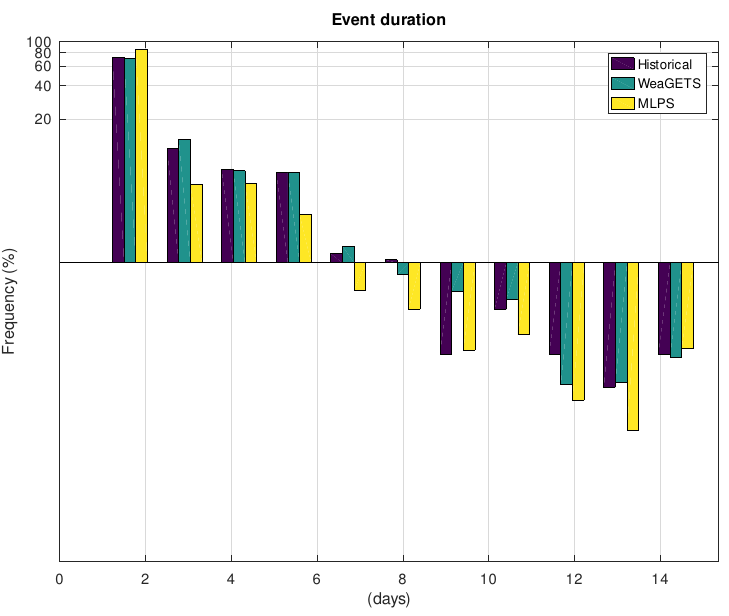
Figure 13. Histogram of the event duration of daily synthetic time series (WeaGETS and MLPS) and historical values of the Gibraltar weather station.